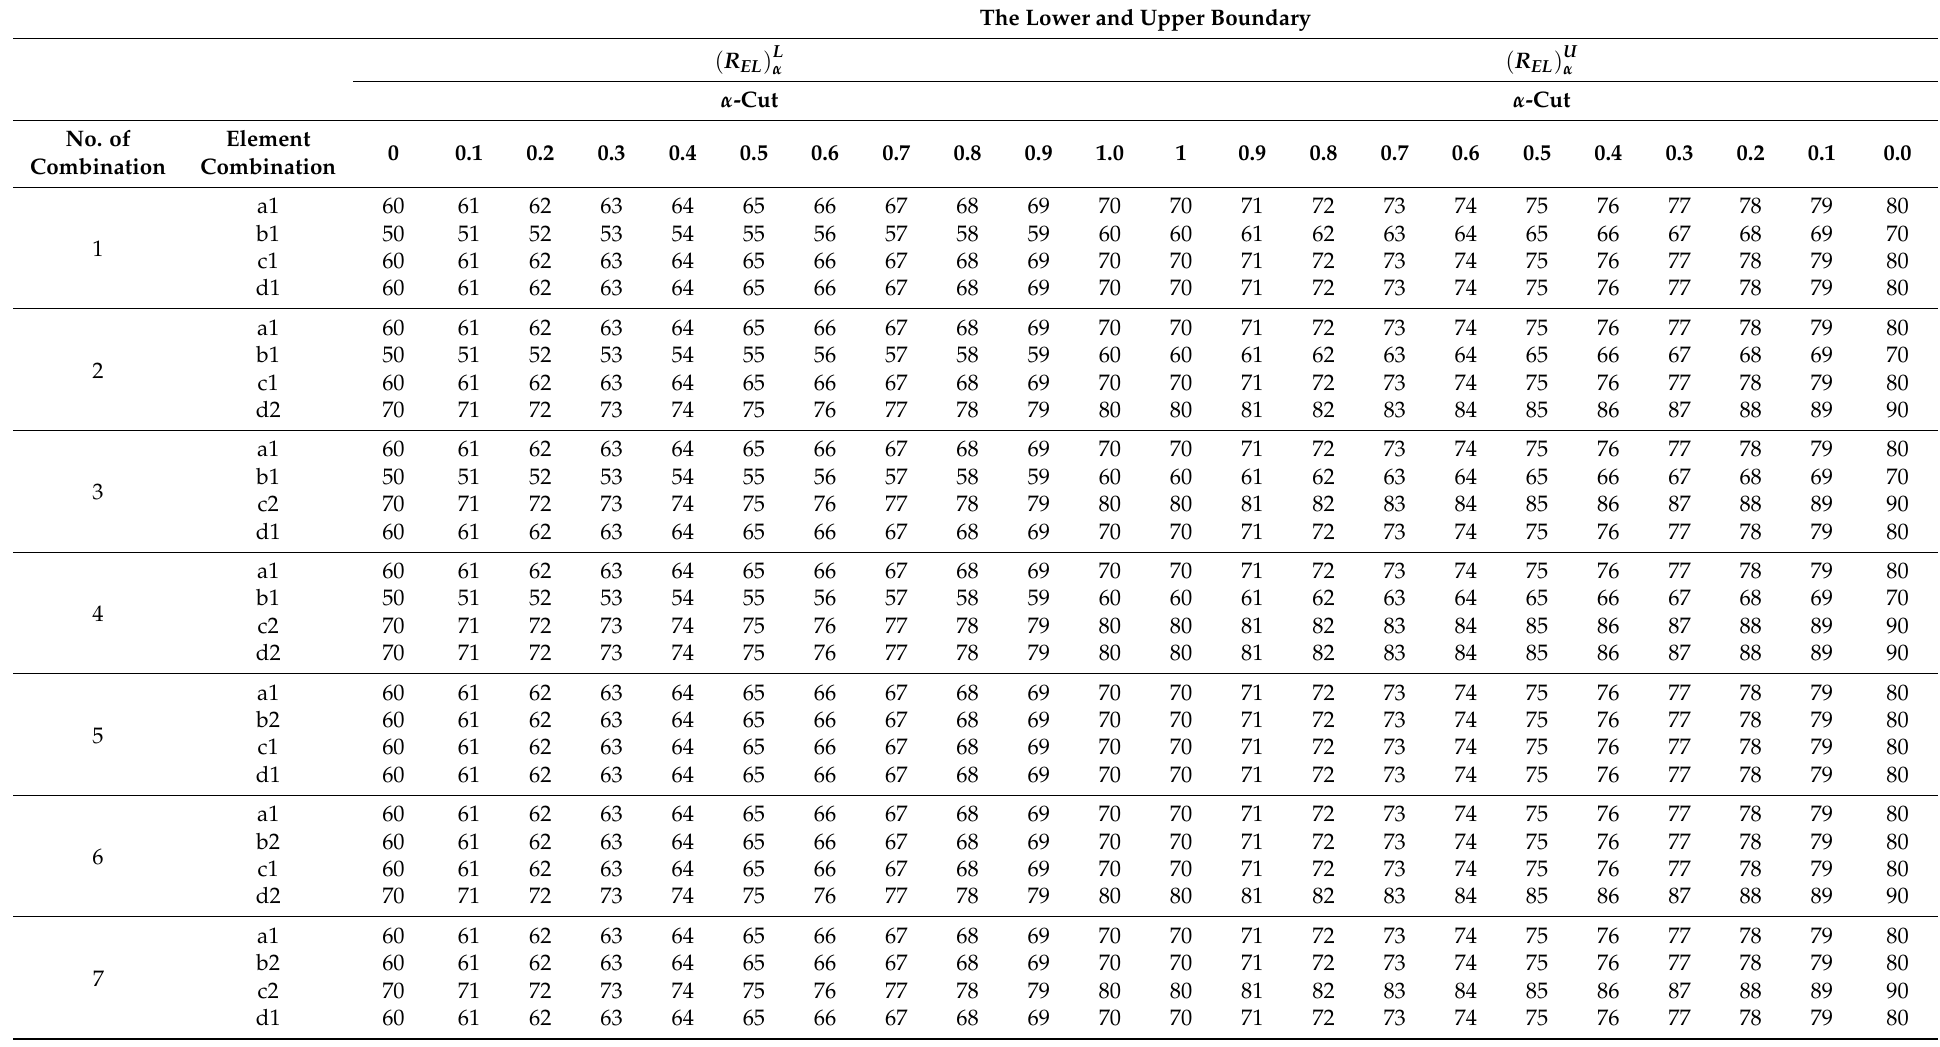
Table A2. The α -cut sets of elements fuzzy ratings according to each combination (extended version of Table